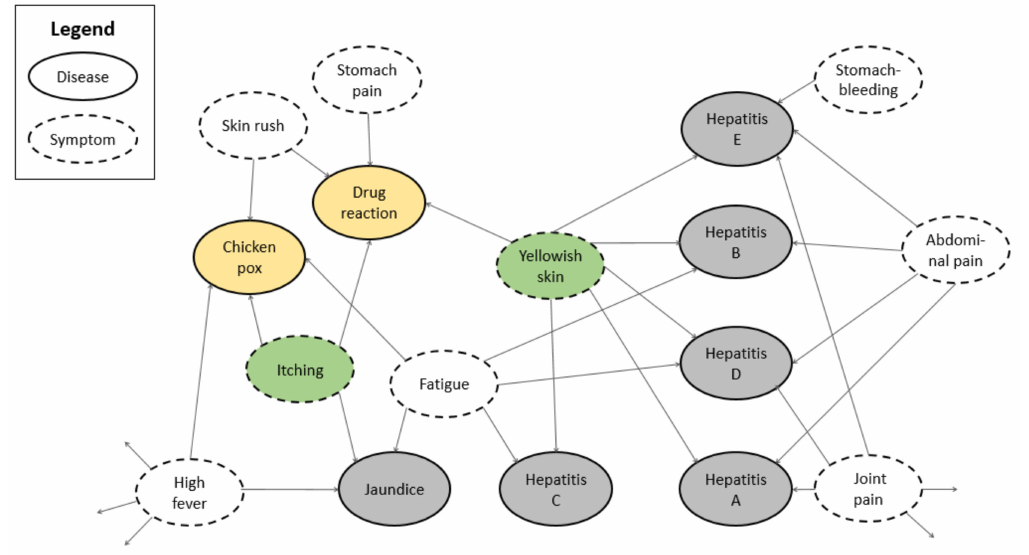
Figure 5. The sub-graph derived from the